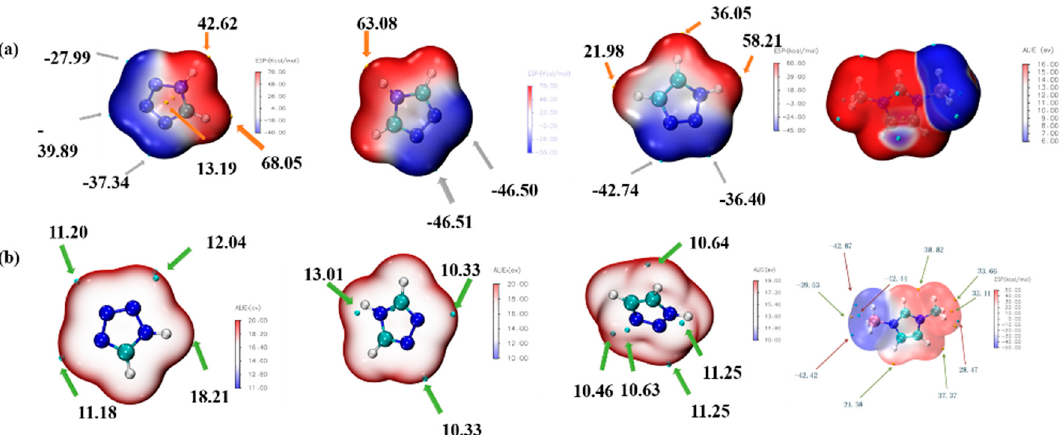
Figure 14. Electrostatic potential mapping (ESP) of 1,2,3,4-tetrazole, 1,2,4-triazole; 1,2,3-triazole and 1-methylimidazole borane complex ( a ); Average local ionization energy mapping (ALIE) of 1,2,3,4-tetrazole, 1,2,4-triazole, 1,2,3-triazole and 1-methylimidazole borane complex ( b ).